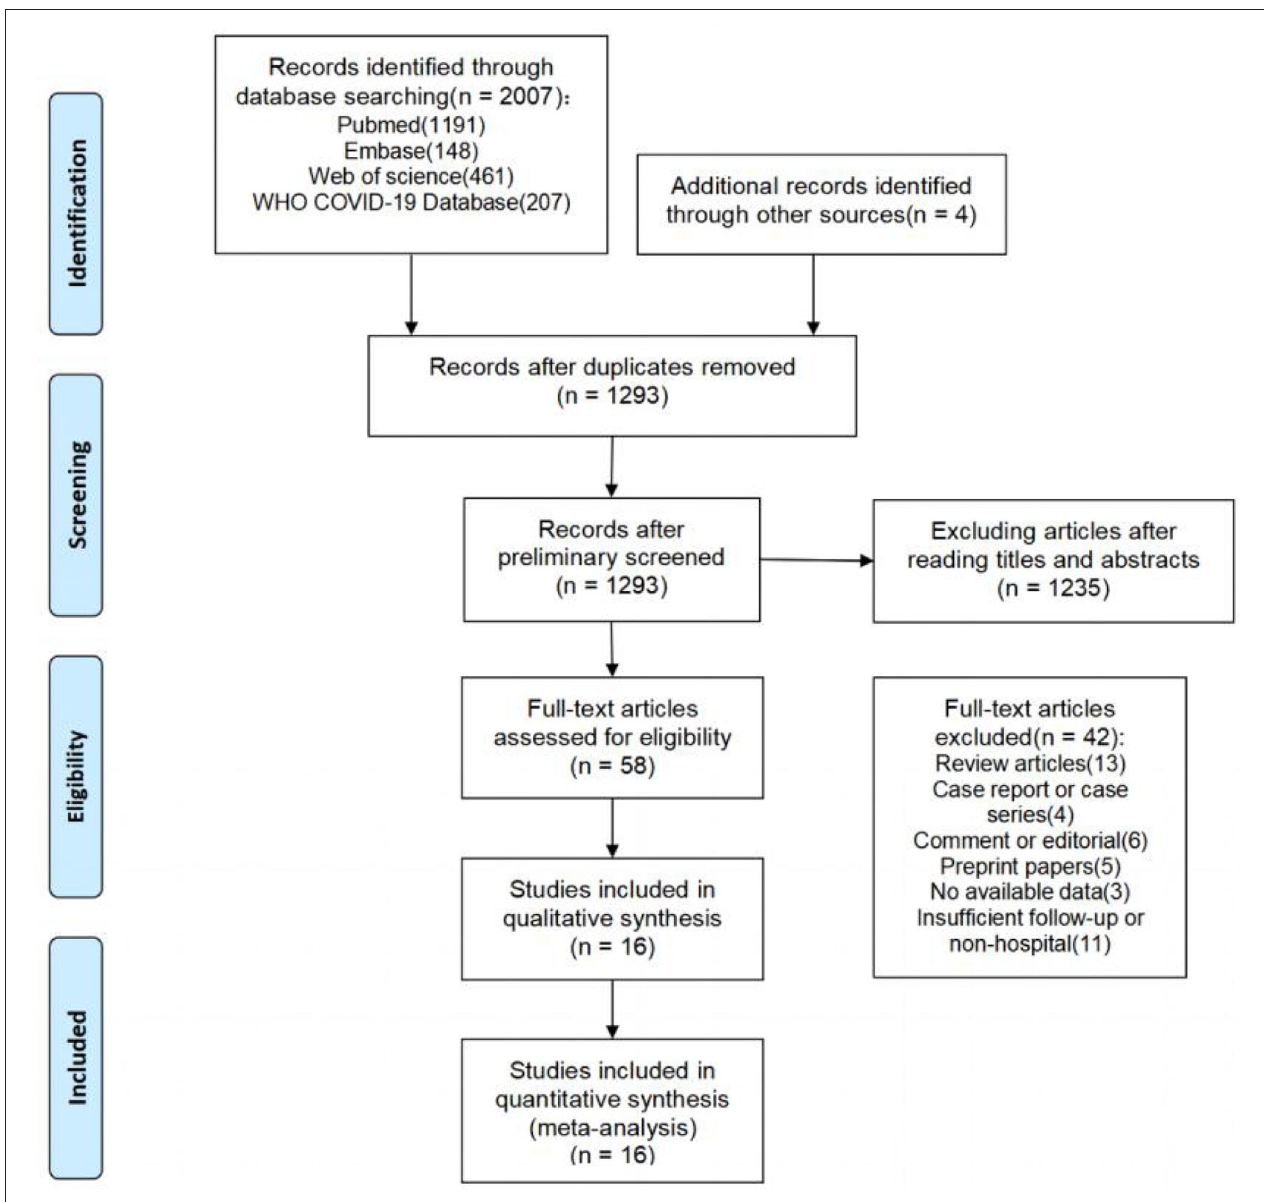
FIGURE 1 | Flow chart of the number of studies screened and included in the